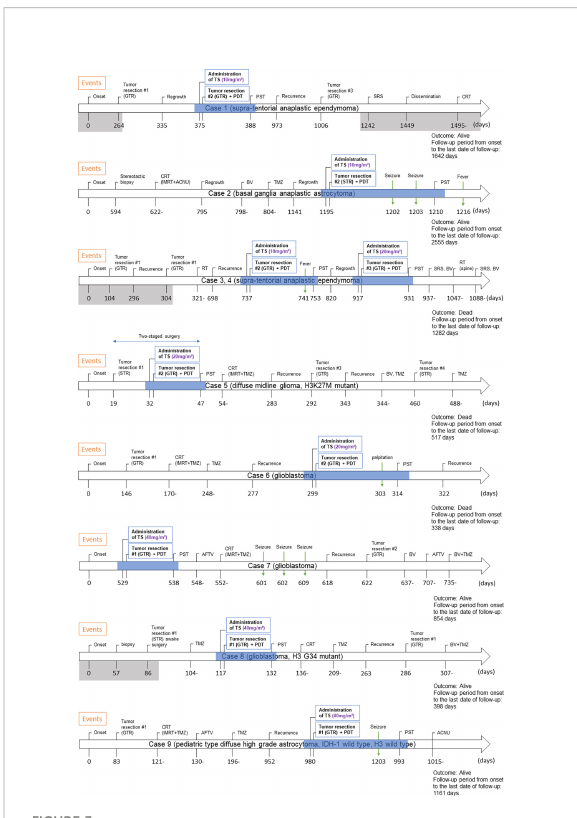
FIGURE 3 Clinical course of eight pediatric cases who underwent PDT. The period shaded in gray is the period of treatment at the previous hospital. The period during which PDT was performed is shown by blue shading. Abbreviations: GTR, gross total resection; TS, talapor fi n sodium; PDT, photodynamic therapy; PST, photosensitivity test; SRS, stereotactic radiosurgery; CRT, chemo-radiotherapy; IMRT, intensity-modulated radiation therapy; ACNU, nimustine hydrochloride; BV, bevacizumab; TMZ, temozolomide; STR, subtotal resection; RT, radiation therapy; AFTV, autologous formalin- fi xed tumor